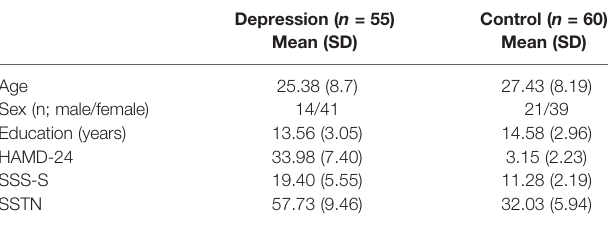
TABLE 1 | Demographic information and participant test scores.